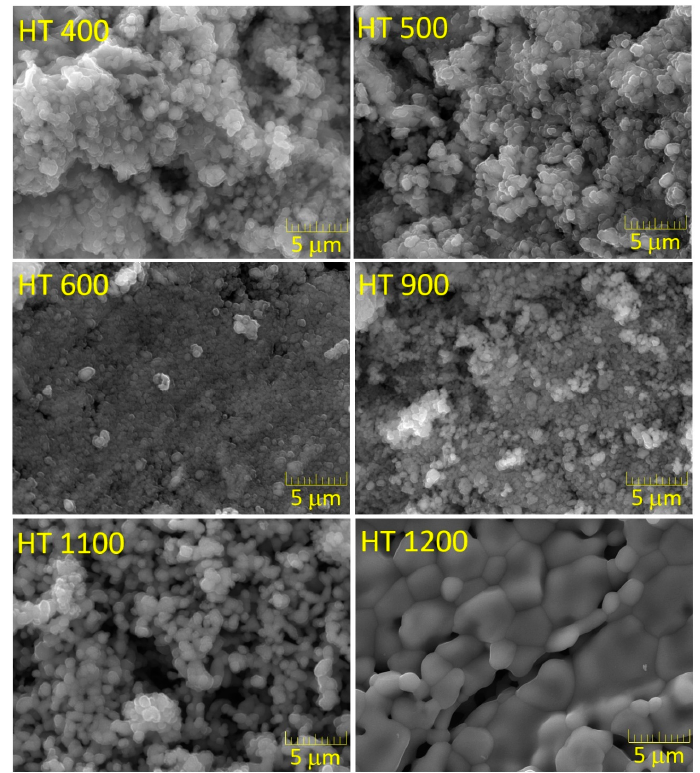
Figure 8. SEM micrographs of the samples prepared via the polymeric gel method.